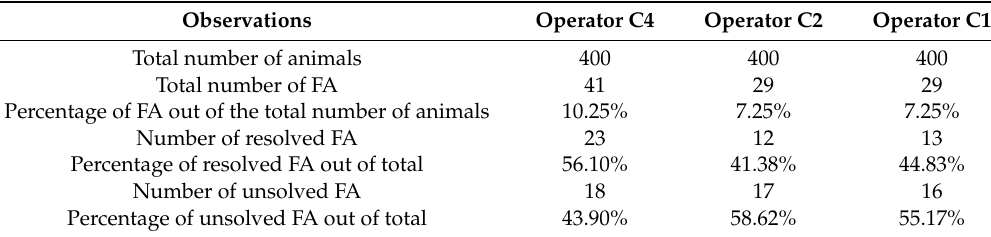
Table 1. Percentage of false aneurysm (FA) presence and their resolution. Observations